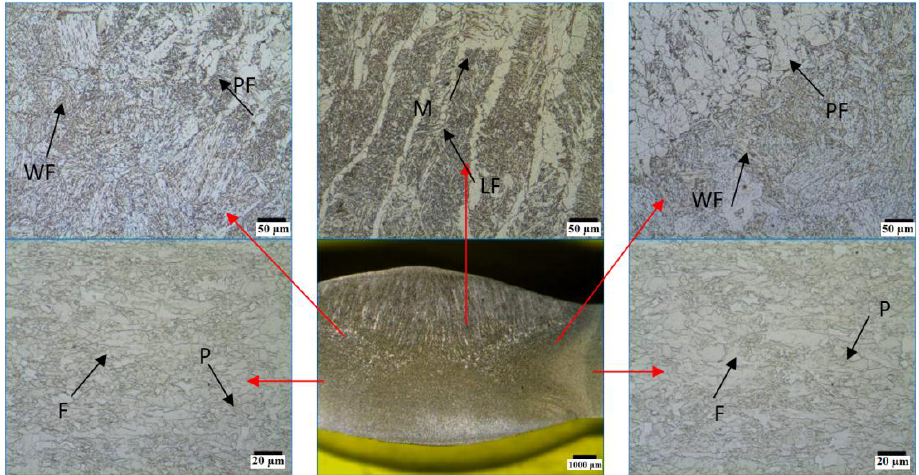
Figure 3. Microstructure of welded sample S2: ferrite (F), pearlite, (P), plate ferrite (LF), martensite (M), polygonal ferrite (PF) and witmanstaten ferrite (WF).